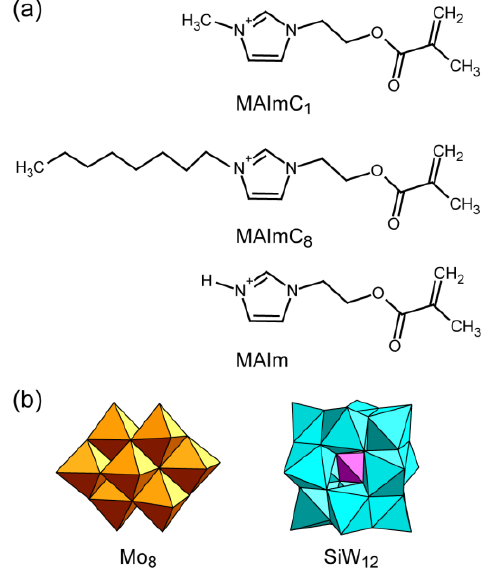
Figure 1. Molecular structures of the components: ( a ) polymerizable ionic liquids of MAImC 1 , MAImC 8 , and MAIm; ( b ) polyoxometalates of β-type octamolybdate (Mo 8 ) and dodecatungstosilicate (SiW 12 ) anions.